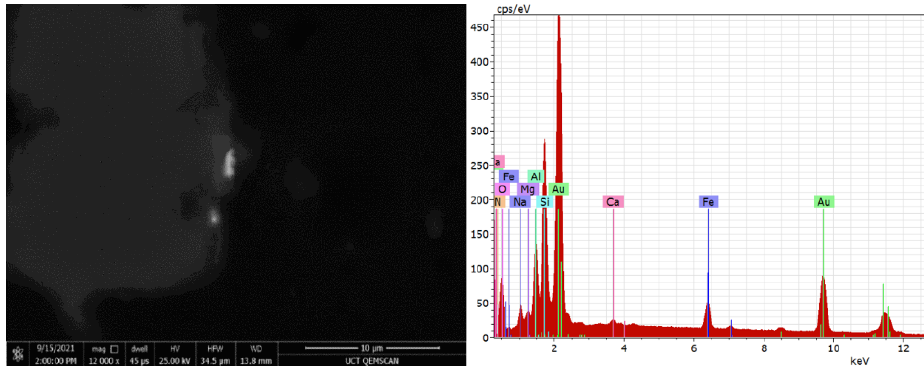
Figure 3. SEM-EDS image of gold particle in chlorite boundary in Sample 3.